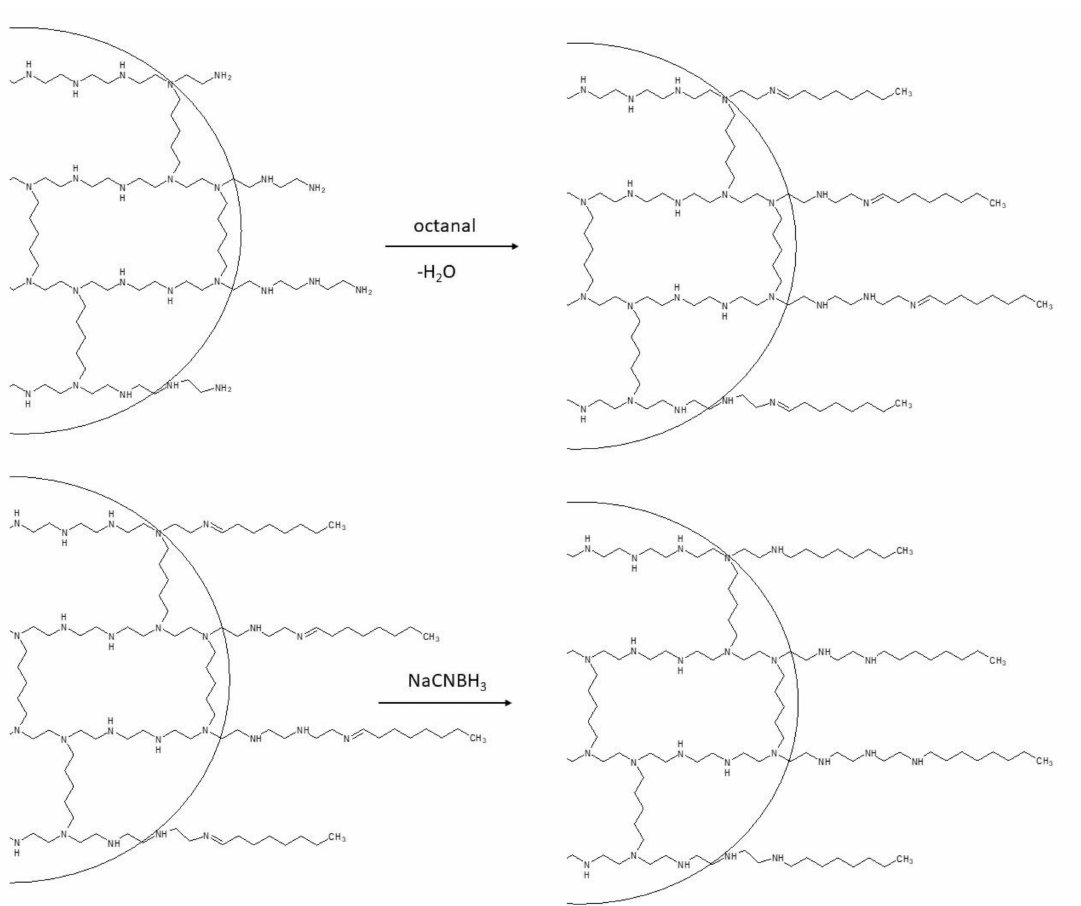
Figure 4. Telomerization in the reductive amination method with the use of octanal. Adapted from